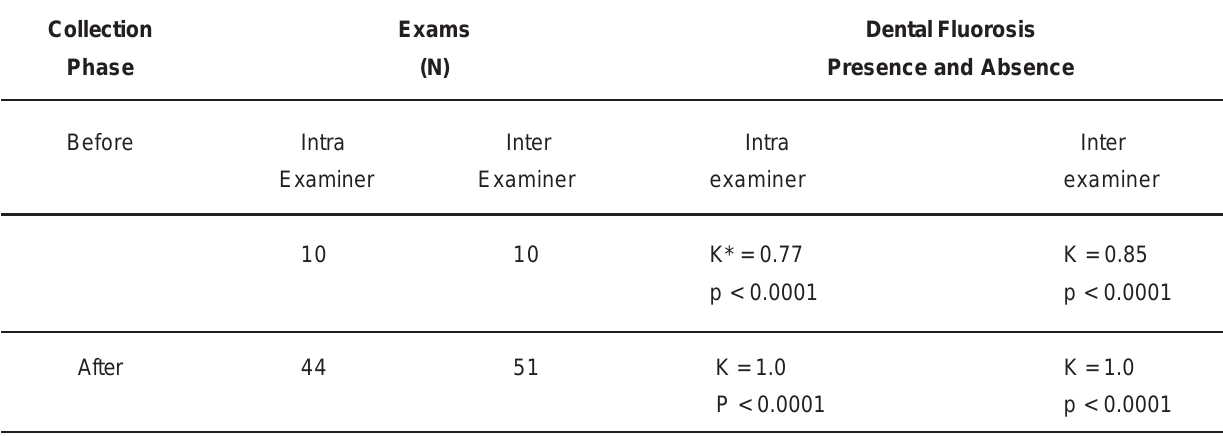
TABLE 1 - Kappa Coefficient Values before and after data collection